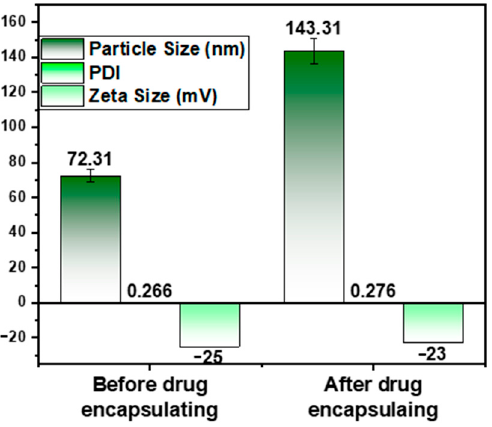
Figure 4. Graphical representation of particle size, PDI, and zeta potential of isoeugenol liposomes before and after encapsulation.